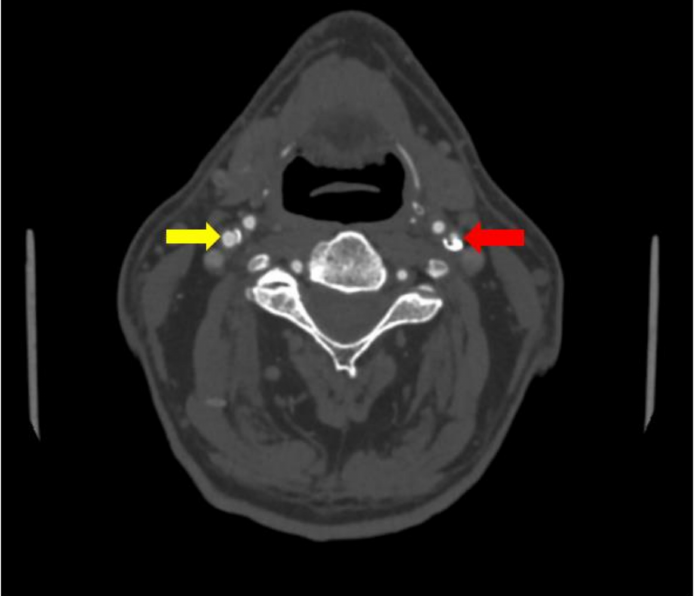
Figure 2. Subocclusion in the proximal segment of the left internal carotid artery (red array) and 30% stenosis in the proximal segment of the right internal carotid artery (CTA) (yellow